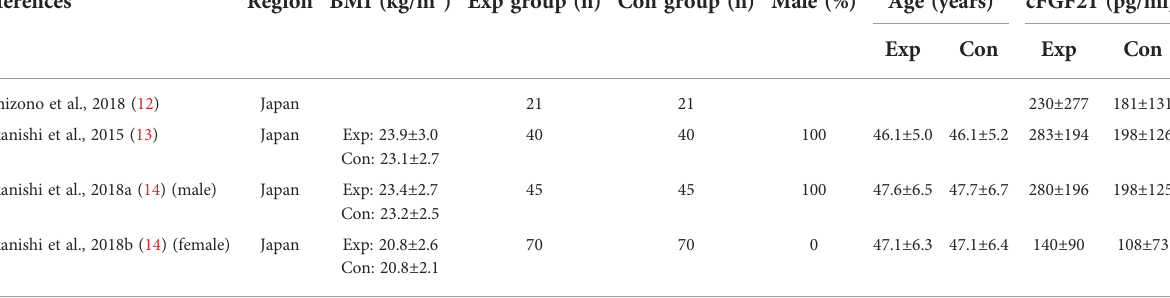
TABLE 1 Baseline characteristics of studies reported cFGF21 concentration in subjects with or without